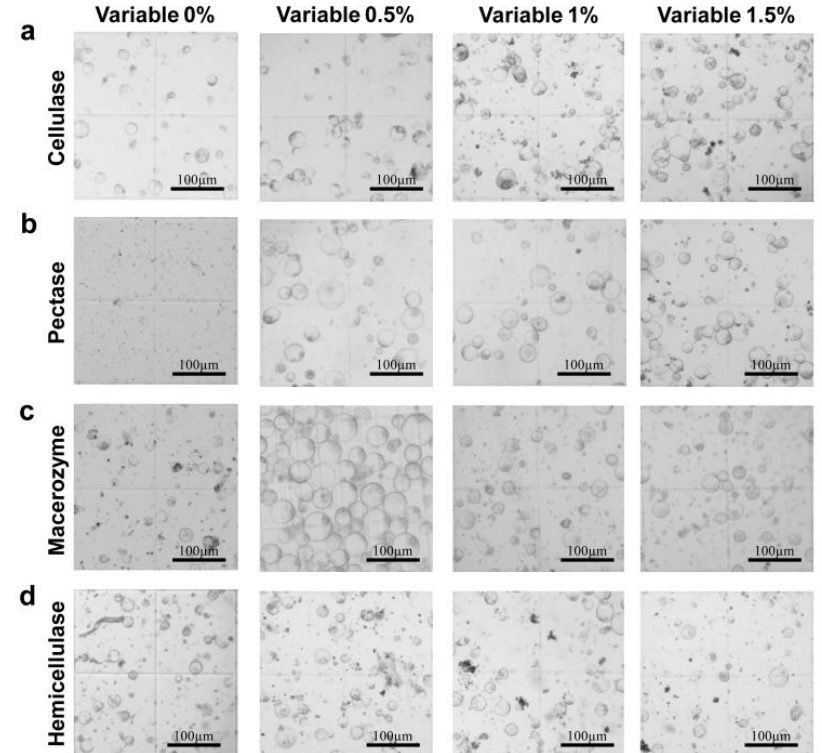
with 1.5% pectinase.